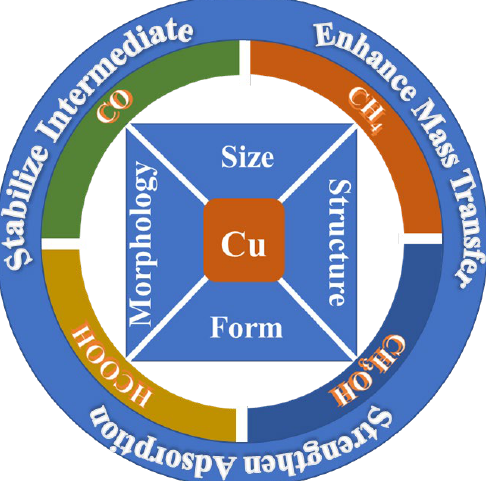
Figure 6. Common C 1 products and key preparation points and optimization strategies for copper- based catalyst preparation.